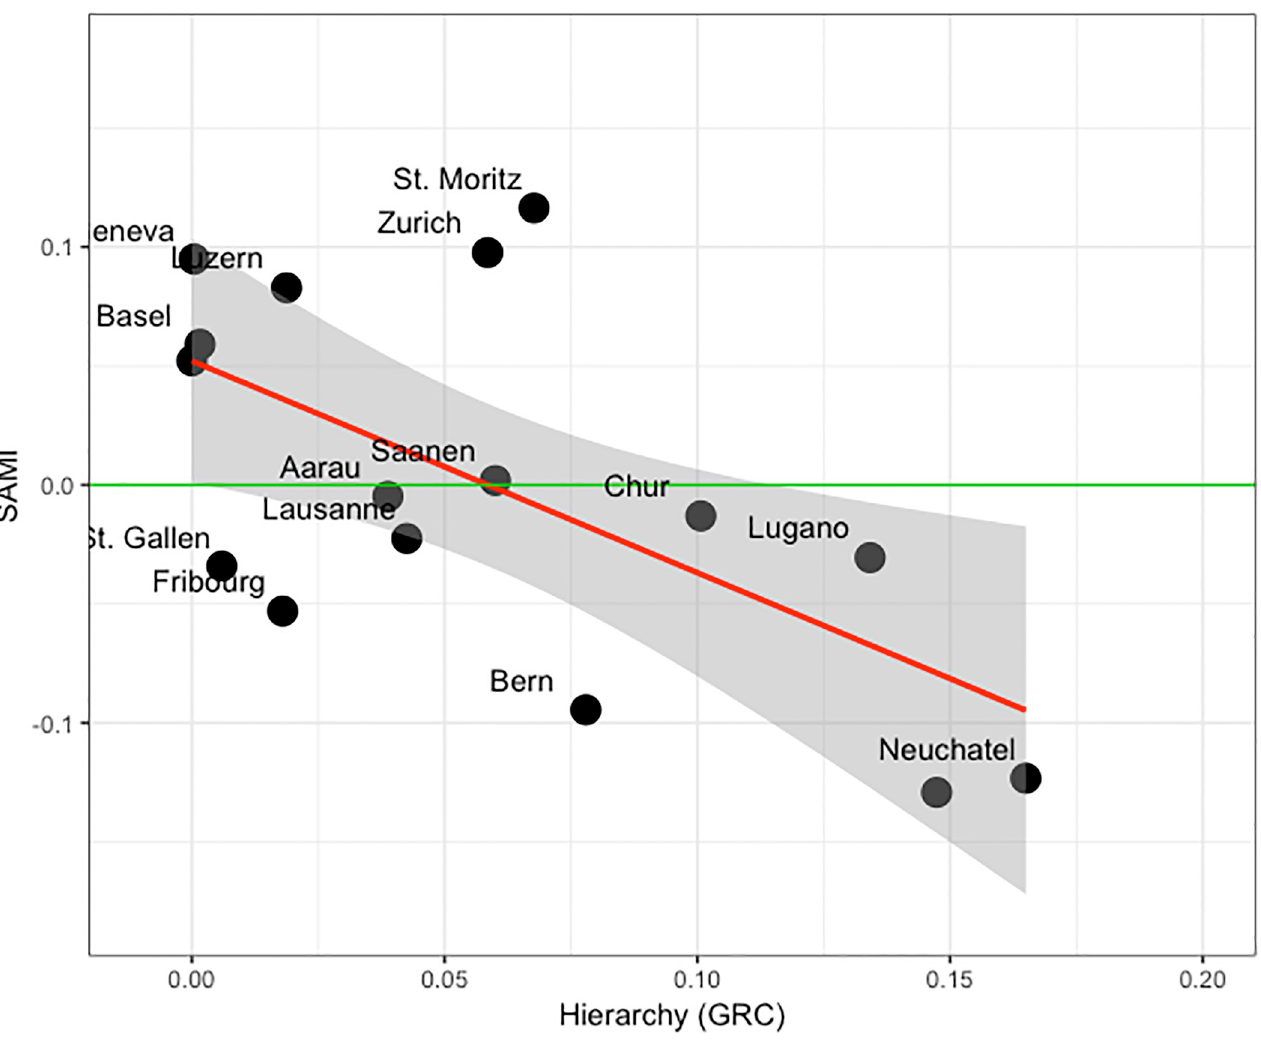
Fig 3. The relationship between hierarchy of settlement network and SAMIs. The red line is the ordinary least squares fit to data points and the green line shows the reference line (SAMI = 0). Metropolitan areas above the green line are associated with a higher economic outcome than expected from urban scaling, while metropolitan areas below the green line have a lower than expected outcome. The grey area indicates the 95% confidence interval.